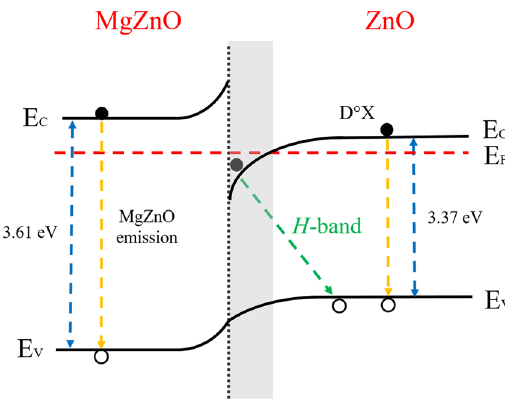
Figure 5. Schematic band diagram of the MgZnO/ZnO heterostructure, showing the recombination channels responsible for the emissions in the bilayer film. Dotted lines represent the excitonic transitions accounting for the observed NBE emissions in ZnO and MgZnO. The H -band arises from the recombination of electrons confined within the triangular quantum well with holes located in the flat-band region of the ZnO valence